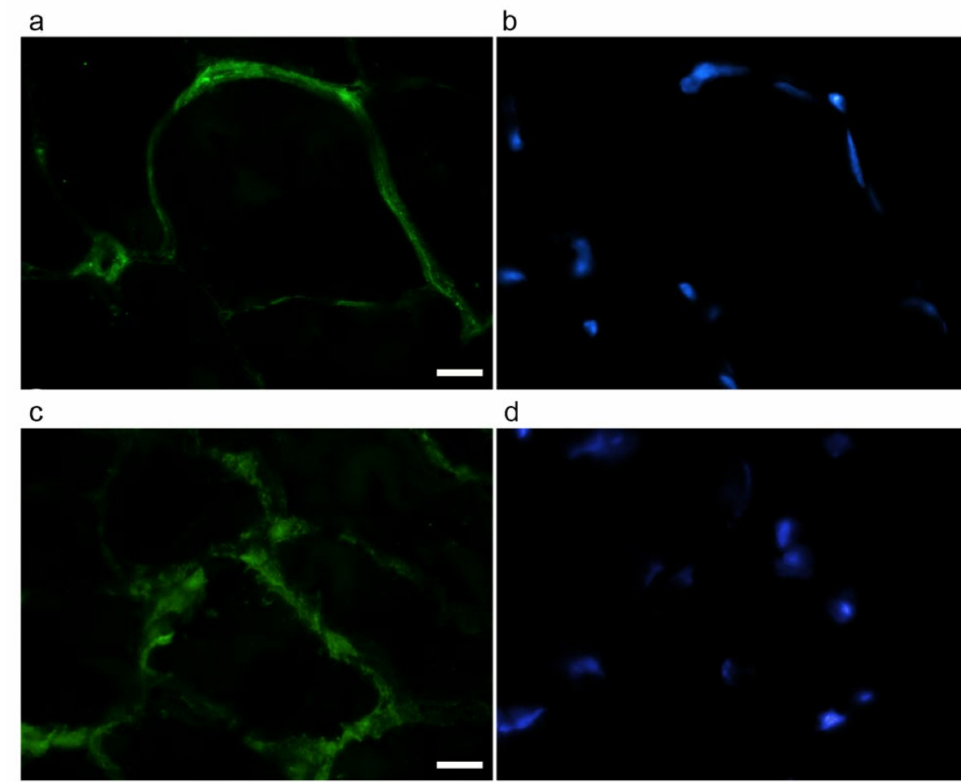
Figure 5. Type I collagen ( a , c ) immunolabelling of gastrocnemius cryosections of adult ( a , b ) and old ( c , d ) mice. DNA was counterstained with Hoechst ( b , d ). Bar: 10 µ